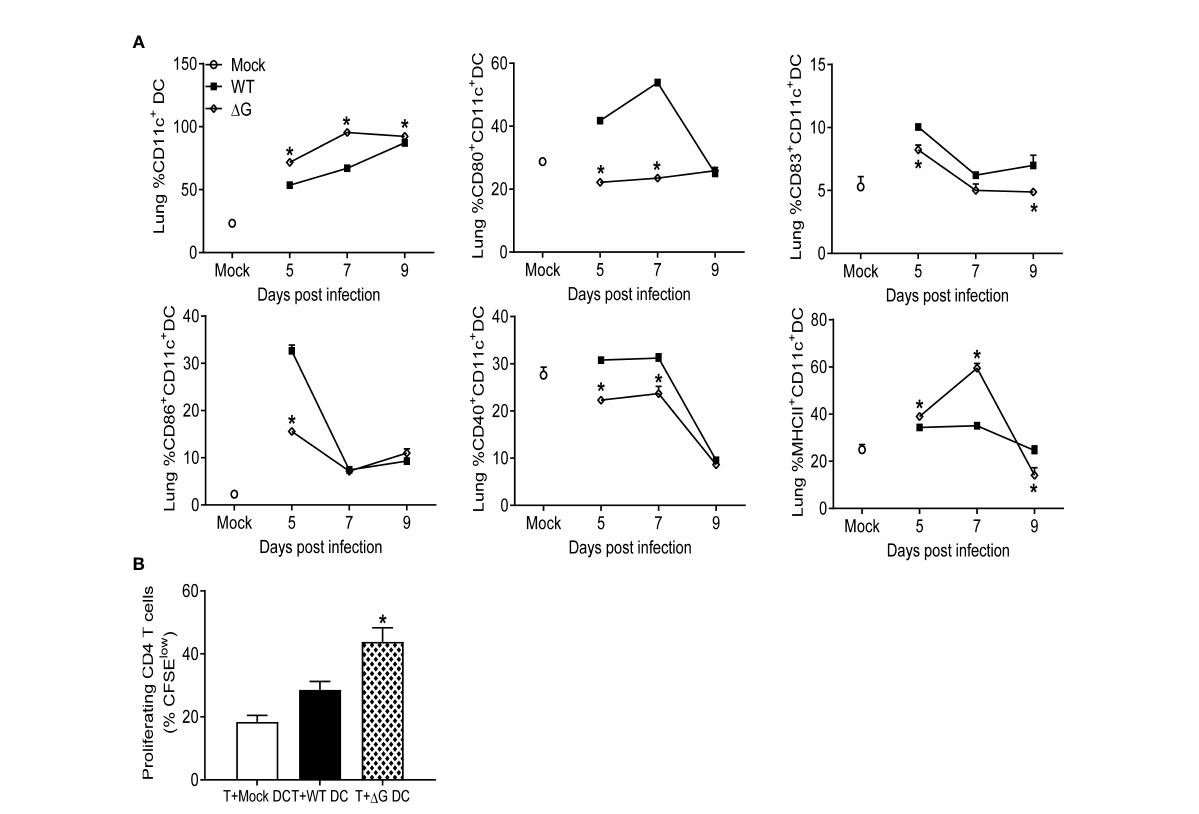
FIGURE 5 Dendritic cells recruitment to the lung, activation, and proliferation. Mice were either infected with rhMPV-WT or - D G or mock-infected and sacri fi ced at various time points p.i. to collect lungs. Single cell suspension of lungs was obtained and stained for DC markers. (A) CD11c + DCs population was enriched from the lung cells and analyzed by fl ow cytometry for the expression of activation markers (CD80, CD83, CD86, CD40, MHC class II). (B) CD11c + cells isolated from lungs of infected mice at day 7 p.i. were loaded with 10 µg/mL of OVA peptide for 2h prior to co-culture with T cells. CD4+ T cells isolated from spleen of DO11.10 mice were labeled with CFSE and co-cultured with DCs at a ratio of 1 ∶ 2 (DC:T). T cell proliferation was measured by CFSE dilution. Cultures without antigen served as controls. The bar graph shows the percentage of proliferating (CFSE low) T cells among the total CD4+ T cell population. * P<0.05 when comparing rhMPV- D G infected mice to rhMPV- WT infected mice. rhMPV - D G = D G; rhMPV -WT =